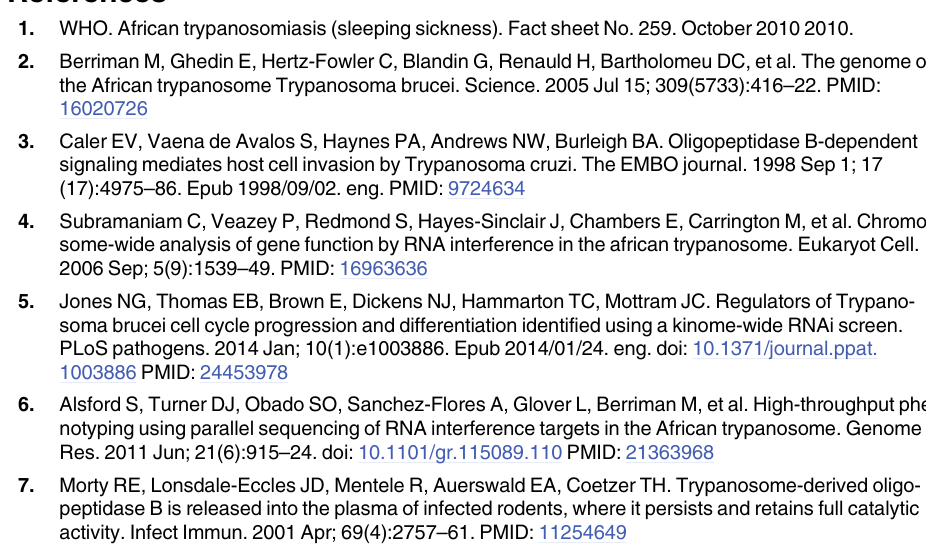
S1 Table. Primer sequences used to amplify RNAi target. S2 Table. Primers used for quantitative PCR. S3 Table. Potential SPP1 substrates. S1 Fig. Alignment of SPPI and recoded SPPI